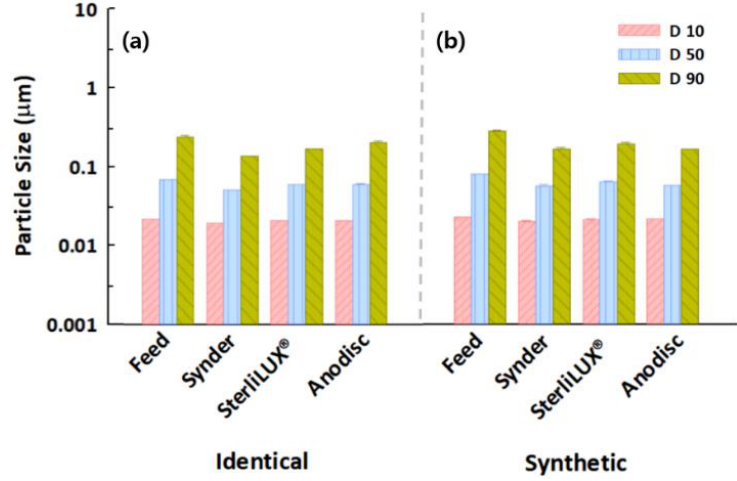
Figure 8. Particle size distribution in the feed and permeate water samples after membrane filtration with the diameter values of the (a) identical and (b) synthetic wastewater for the 0.1 μm PS microplastics.